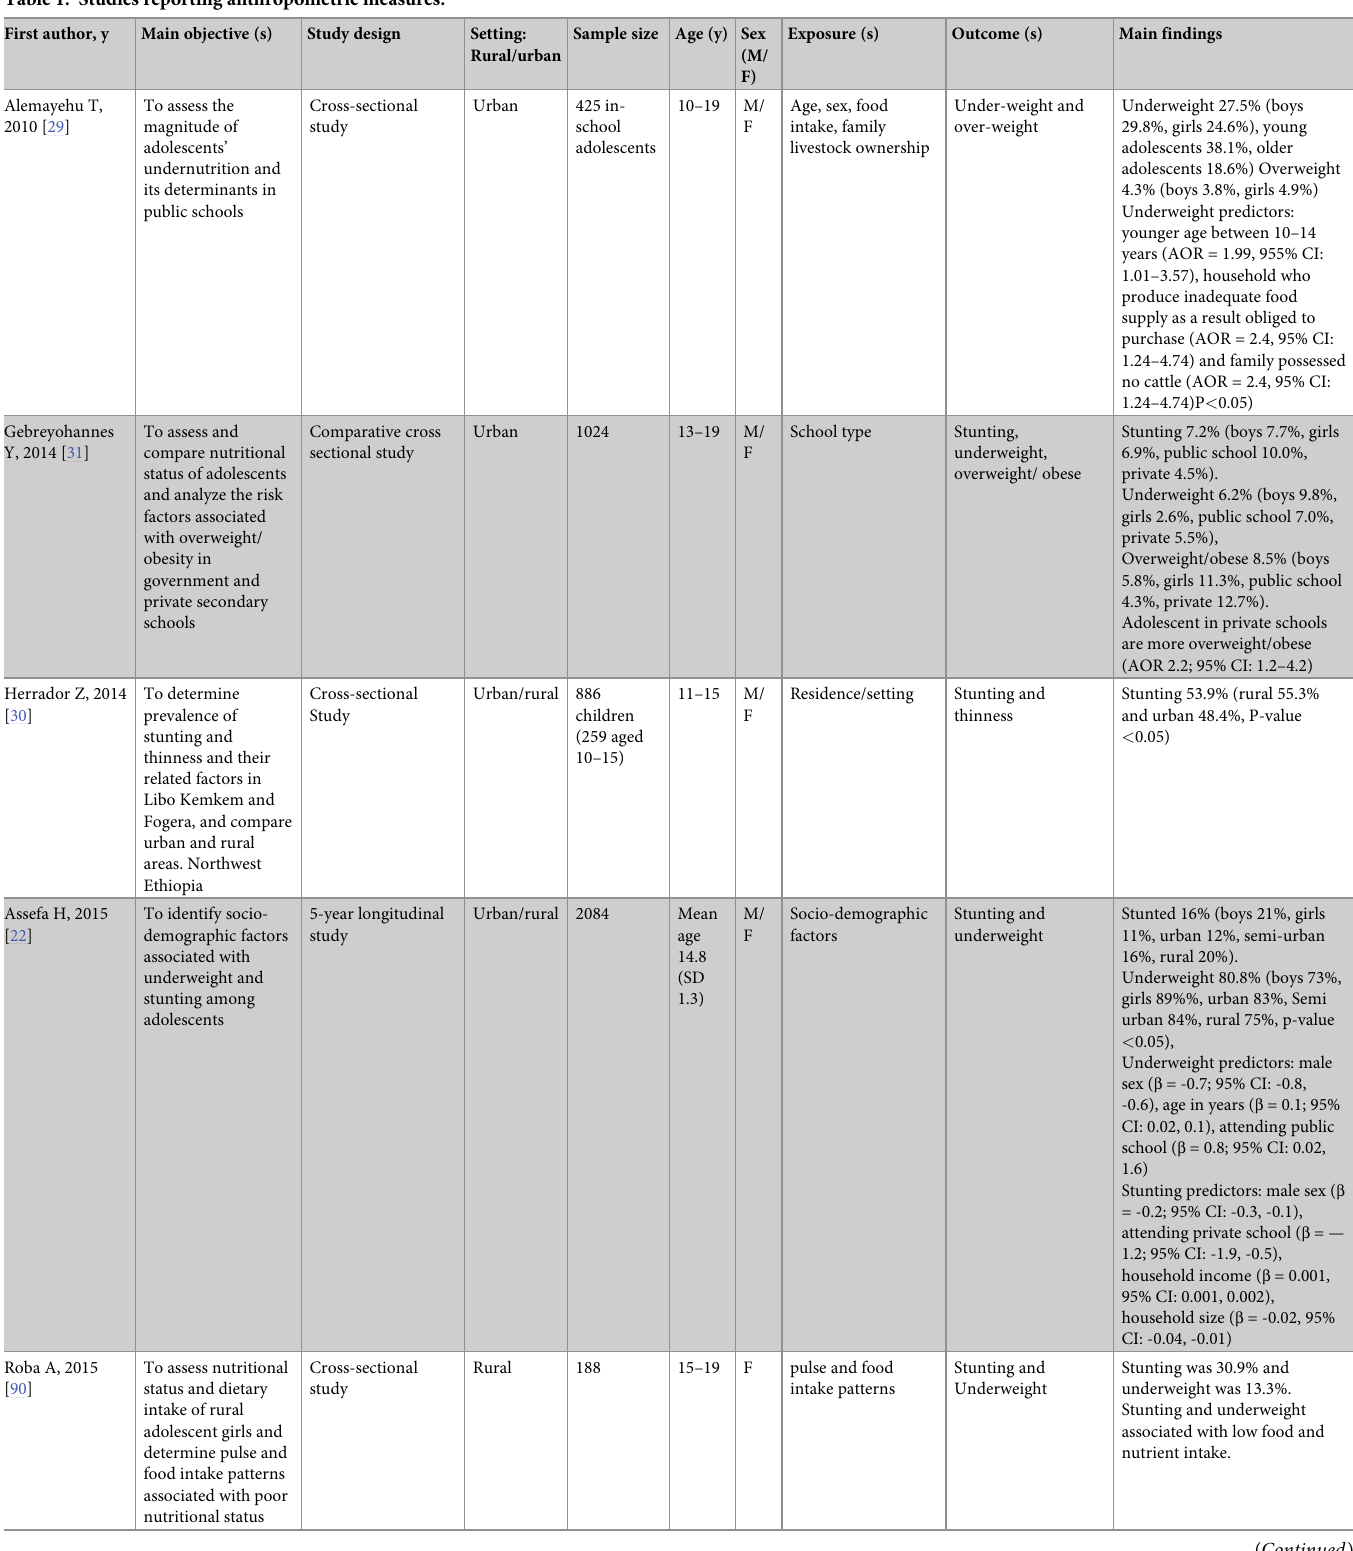
Table 1. Studies reporting anthropometric